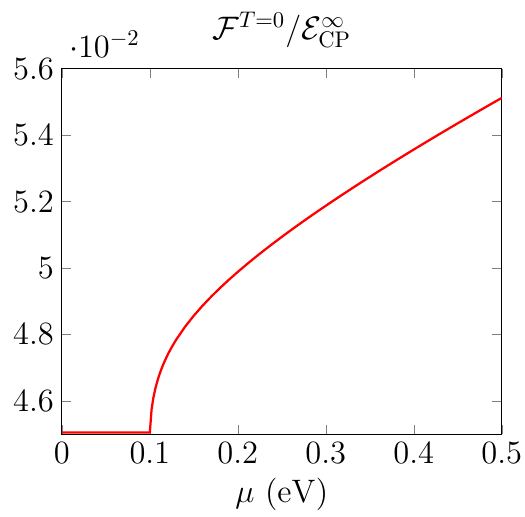
T = 0 , as a function of chemical potential µ F